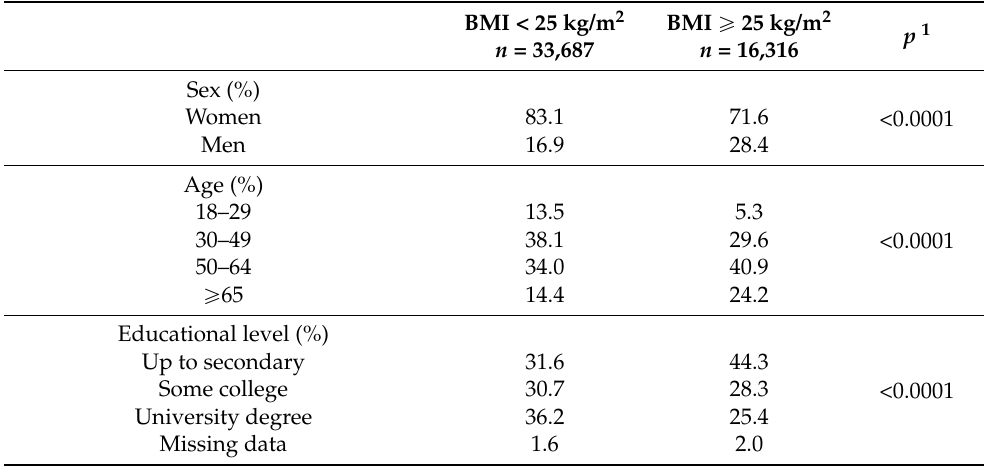
Table 1. Individual characteristics of participants according to weight status ( n = 50,003; NutriNet-Santé cohort